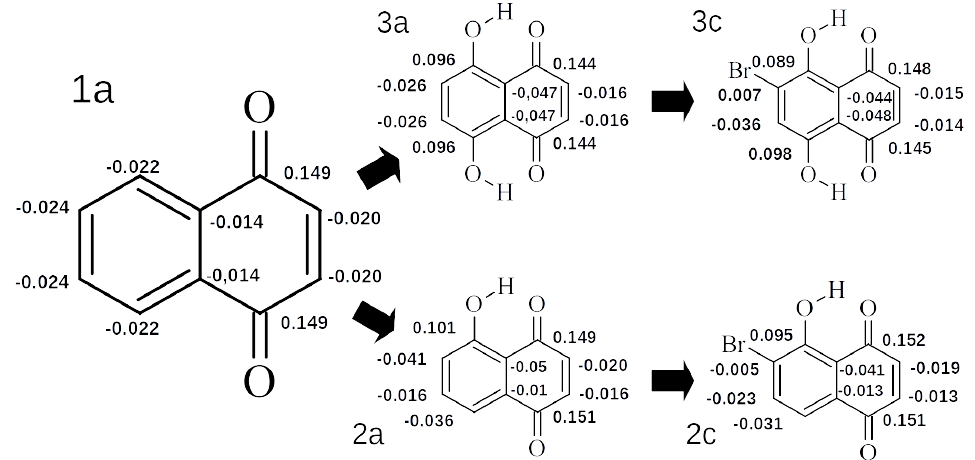
Figure 7. The Hirshfeld atomic charge distribution in 1,4-naphthoquinone and its exemplary deriva- tives. The values of carbon atoms are